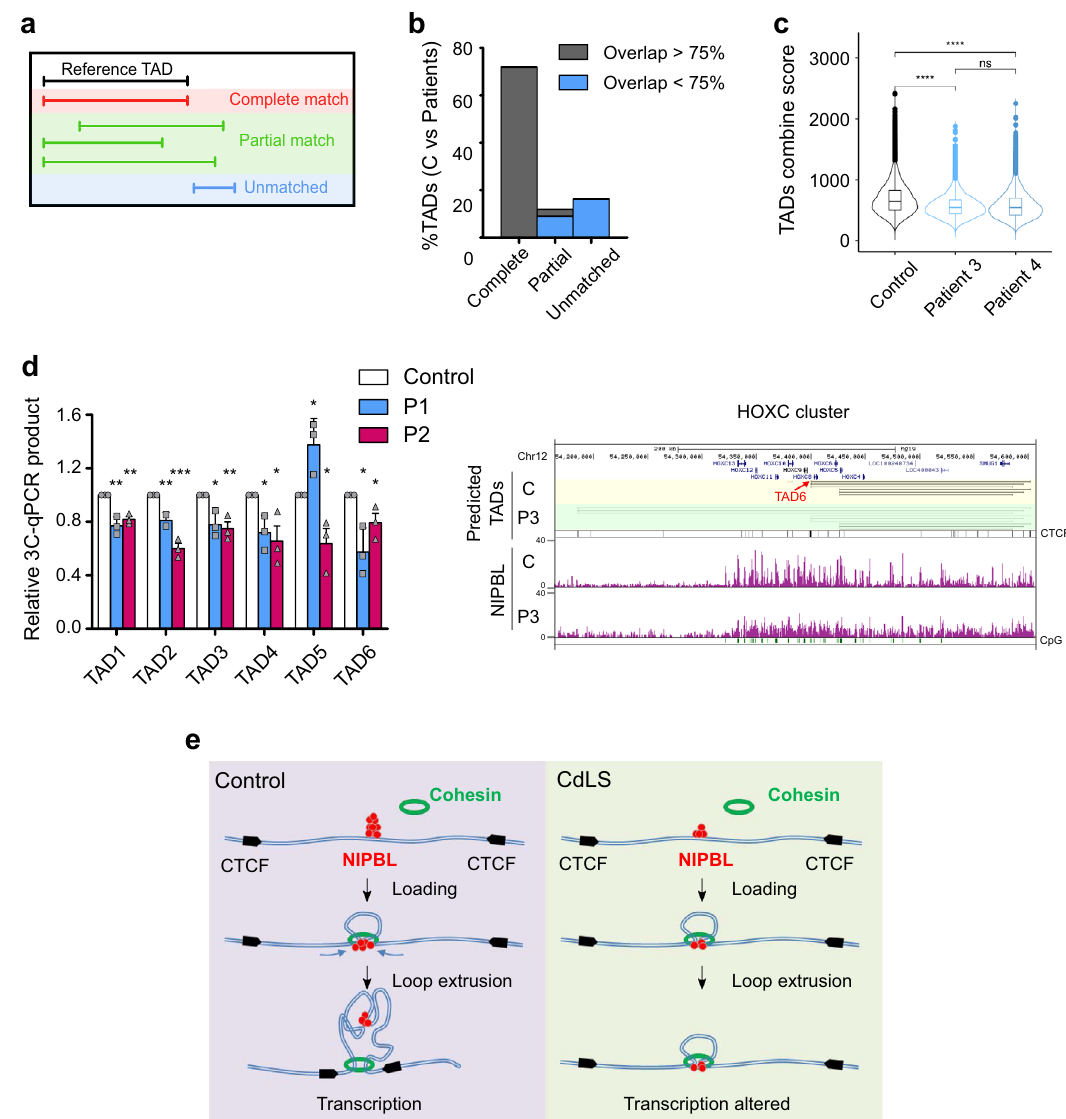
Fig. 7 Reduction of chromatin contacts in CdLS patient-derived fi broblasts. a Cartoon representing the complete (red), partial (green), and unmatched (blue) intra-TADs (see “ Methods ” for more details). b Bar plot showing the percentage of the predicted intra-TAD loops from CdLS patients completely (71.9%), partially (11.8%), or unmatching (16.3%) with the control intra-TADs. TADs with an overlap of more than 75% are considered unchanged (gray) between the control and the patients. TADs with an overlap lower than 75% are considered different between the control and the patients (blue). c Boxplots and violin plots representing the intra-TAD combined scores predicted for control (black), patient 3 (light blue), and patient 4 (steel blue). Boxplots: center line, median; box limits, fi rst and third quartiles; whiskers, 1.5× interquartile; points, outliers. Violin plots show the corresponding probability density function. Two-sided Wilcoxon test (**** p < 0.0001). d Validation of the intra-TAD loops prediction by 3C-qPCR experiments from a control and two CdLS patients from biological triplicates. Means and SEMs are shown. Two-sided unpaired student ’ s t -test (*** p < 0.001; ** p < 0.01; * p < 0.05). Snapshot of a representative intra-TAD loops prediction is depicted (right). e A model for the differential NIPBL and cohesin genomic distribution in CdLS patient-derived cells. Under normal conditions NIPBL (red) is enriched in regions of high GC content, including promoters, enhancers, and gene clusters. Cohesin (green) is recruited at the NIPBL-occupied positions and reaches their fi nal cohesin-CTCF (black) sites by DNA translocation and loop extrusion formation (left). NIPBL chromatin association is greatly reduced in CdLS-derived cells. Defective NIPBL function might reduce cohesin DNA translocation and/or loop extrusion kinetics. Cohesin peaks increase at the NIPBL-occupied positions and reduce at the cohesin-CTCF sites